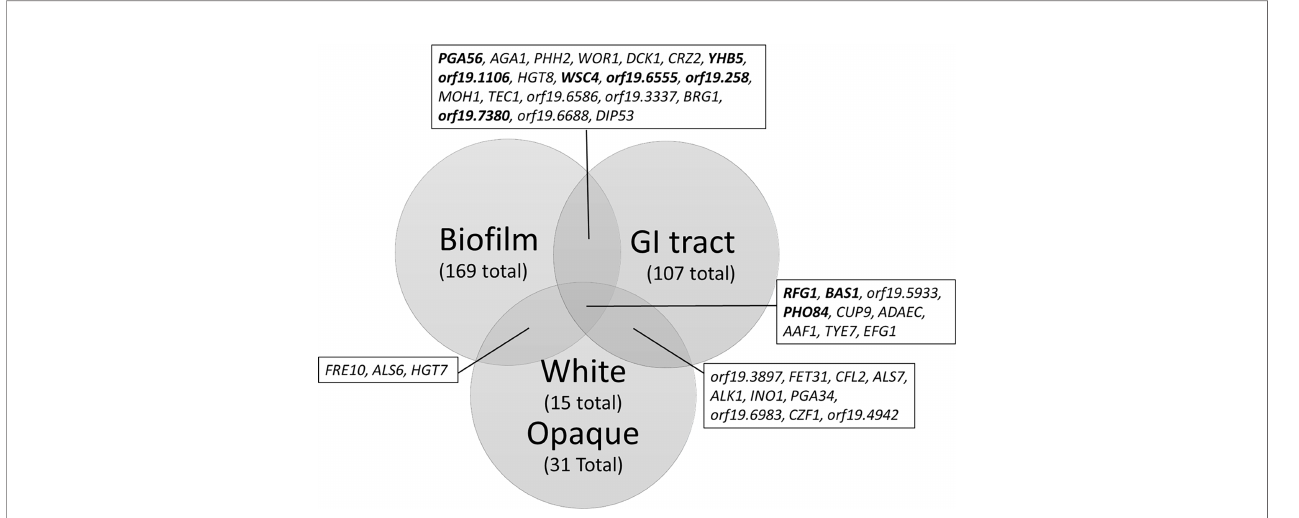
FIGURE 2 | Venn Diagram of Efg1 targets during bio fi lm formation, gut commensalism, and either the white or opaque state. Transcriptomic studies comparing the efg1 D / D deletion mutant and wild type strains under the conditions listed were used to determine transcripts with twofold changes in expression upon deletion of EFG1. Transcripts were then fi ltered by whether Efg1 is able to bind to the promoter regions of the encoding gene to create a list of Efg1 targets with differential expression upon deletion of EFG1. Bold identi fi es transcripts that are differentially regulated (upregulated in one condition, downregulate in another). Data adapted from (Nobile et al., 2012; Hernday et al., 2013; Witchley et al.,